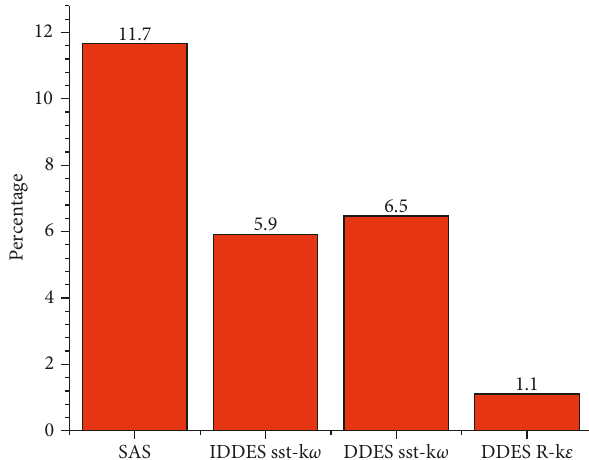
Figure 6: Percentage of the cylinder W relative to LES.